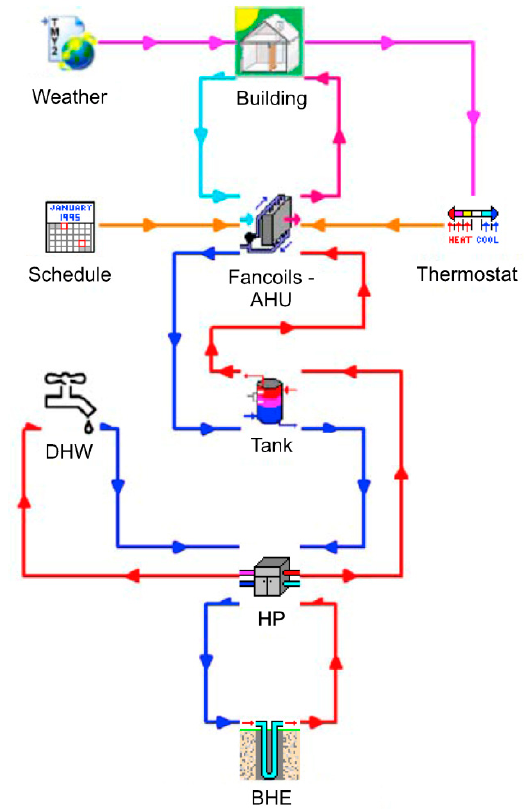
Figure 2. Building-HVAC integrated model on TRNSYS Studio. (AHU, Air Handling Unit; DHW, Domestic Hot Water; HP, Heat Pump; BHE, Borehole Heat Exchangers).